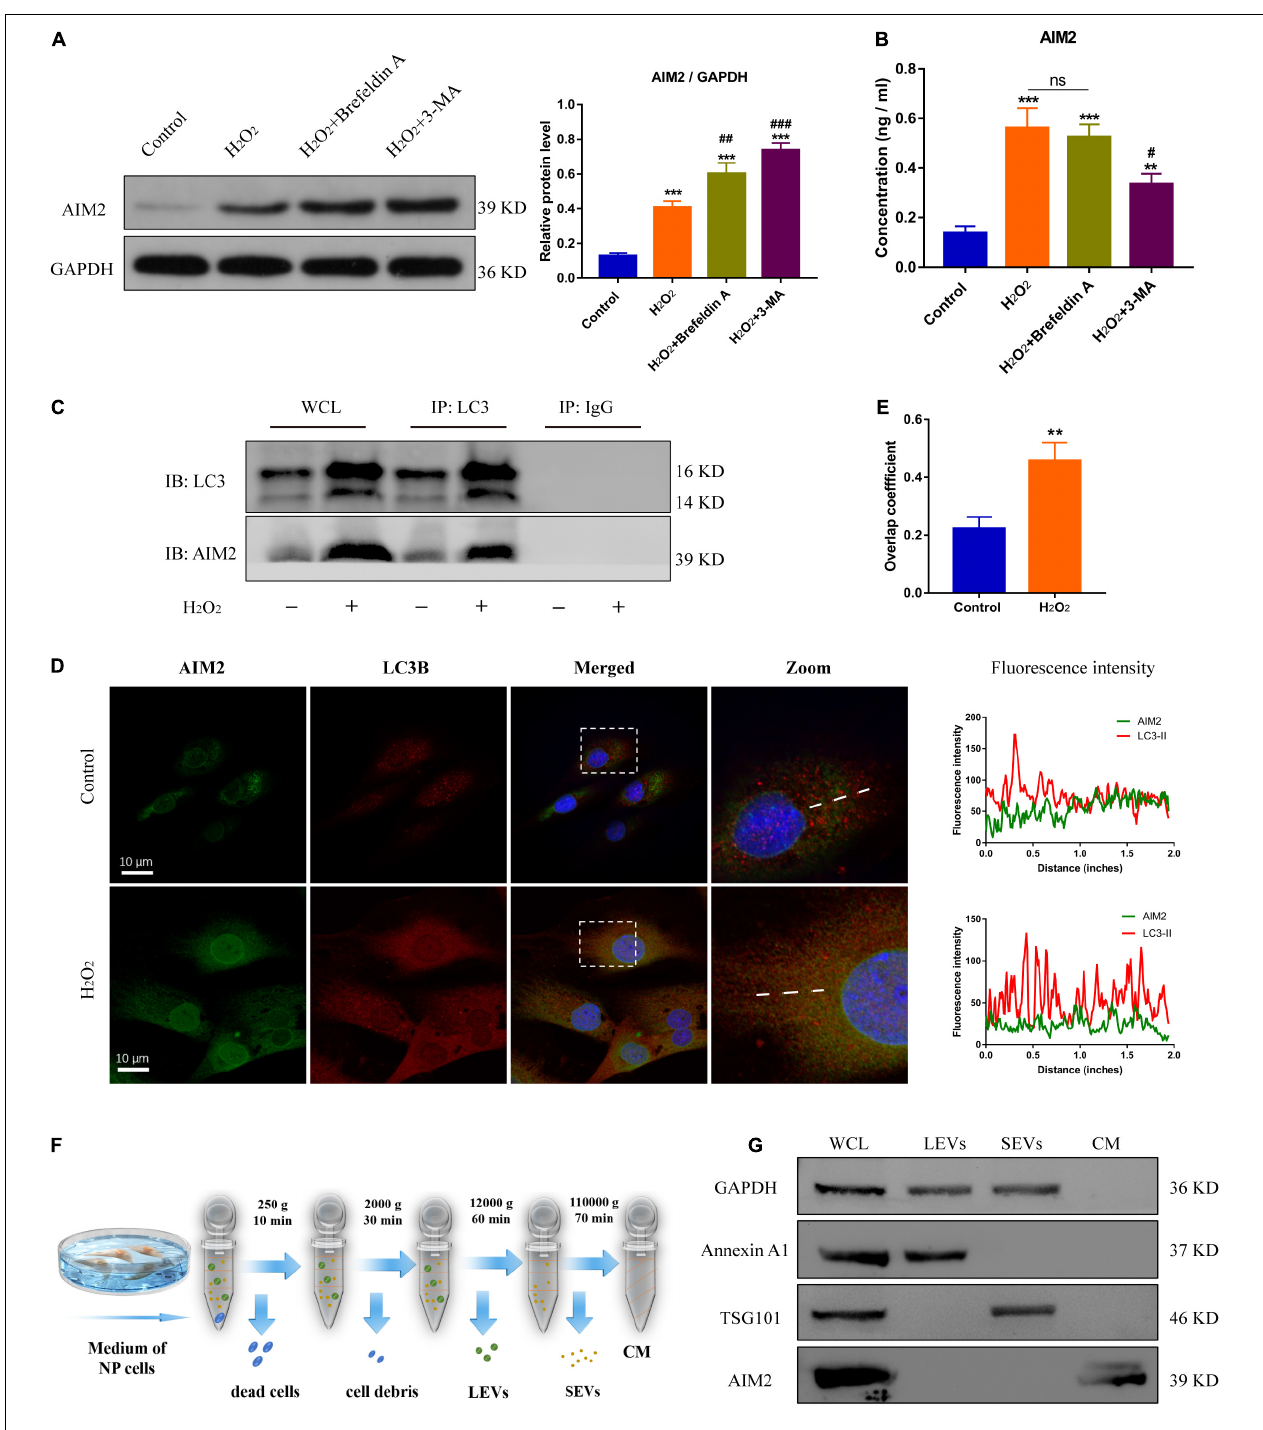
FIGURE 5 | Autophagic secretory of AIM2 is independent of extracellular vesicles. (A) Protein levels and quantification of AIM2 in H 2 O 2 -treated NP cells co-treated with Brefeldin A (1 µ g/ml, 8 h) or 3-MA. (B) Secretion of AIM2 measured by ELISA analysis in different groups. (C) Immunoprecipitation for LC3 was conducted to detect the integration of AIM2. IgG was as a negative control. WCL, whole cell lysate. (D) Confocal images of AIM2 (green) and LC3B (red) and fluorescence intensity results. (E) Overlap coefficient based on immunofluorescence images showed the colocalization between AIM2 and LC3B. Data were presented as the means ± SD, n = 3. ** P < 0.01, *** P < 0.001 vs. control group; # P < 0.05, ## P < 0.01, ### P < 0.001 vs. H 2 O 2 group. (F) Workflow showed the isolation protocols and definition of extracellular vesicle fractions. LEVs, large extracellular vesicles; SEVs, small extracellular vesicles; CM, culture medium without extracellular vesicles. (G) Western blot analysis of extracellular vesicle markers and AIM2 in the different fractions. Annexin A1, a marker of LEVs; TSG101, a marker of SEVs; WCL, whole cell lysate.